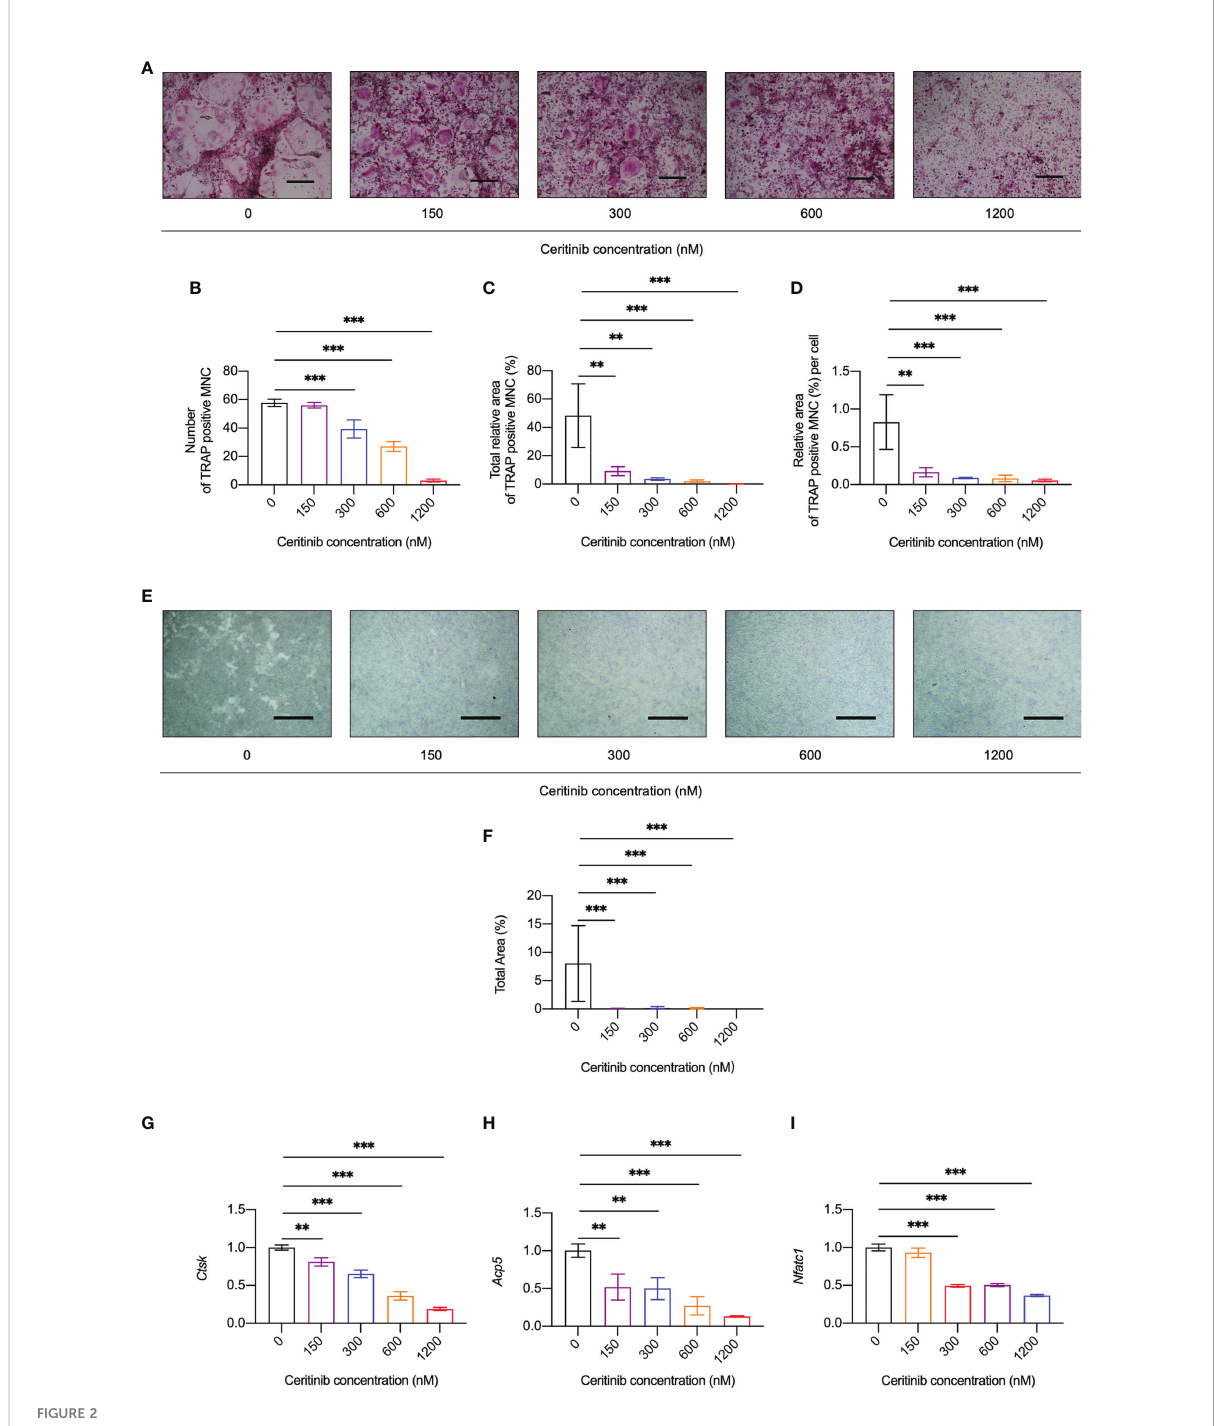
FIGURE 2 Ceritinib inhibited osteoclast differentiation and osteoclast-speci fi c gene expression in vitro . (A) TRAP staining displayed diminishing tendency of osteoclast differentiation upon treatment with ceritinib (150, 300, 600, and 1200 nM). Scale bar = 10 µm. Statistical graphs show signi fi cantly reduced numbers (B) as well as decreased total (C) or per cell (D) area (%) of TRAP-positive MNCs upon treatment with different doses of ceritinib. (E) Bone resorption assay using hydroxyapatite-coated microplates showed a larger area of resorption pits after treatment with ceritinib (150, 300, 600, and 1200 nM). Scale bar = 200 m m. (F) Statistical graphs show signi fi cantly reduced total resorption area (%) upon treatment with different relative doses of ceritinib. MNC, multinucleated cell. The mRNA expression levels of osteoclast differentiation-related genes, Ctsk (G) , Nfatc1 (H) , Acp5 (I) , decreased upon ceritinib treatment (150, 300, 600, and 1200